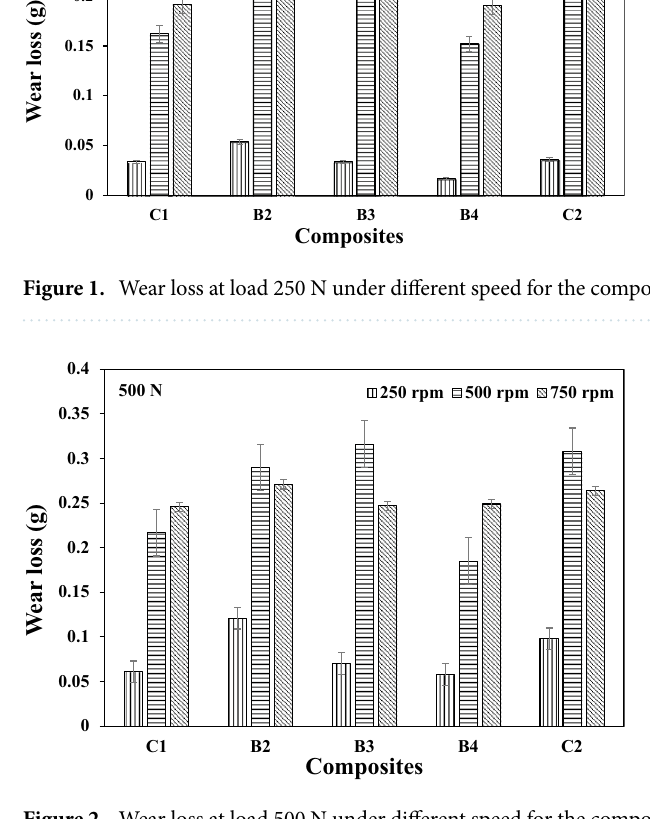
Figure 2. Wear loss at load 500 N under different speed for the